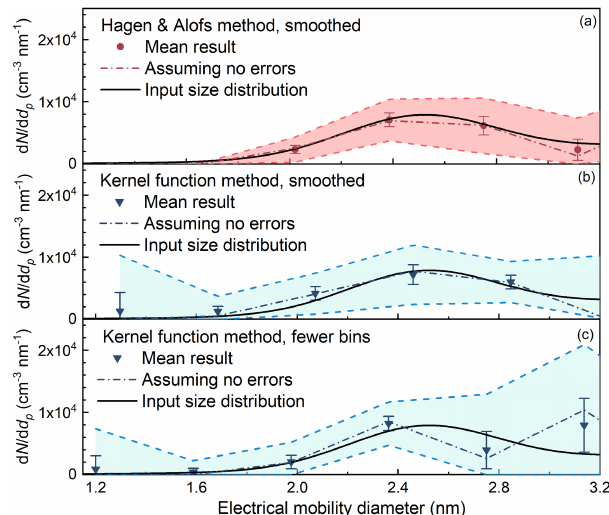
Figure 9. Comparisons of the inverted results using (a) the H&A method smoothing the particle size distribution via merging size bins; (b) the kernel function method smoothing the particle size dis- tribution via merging size bins; and (c) the kernel function method assuming fewer discrete particle sizes in Eq.